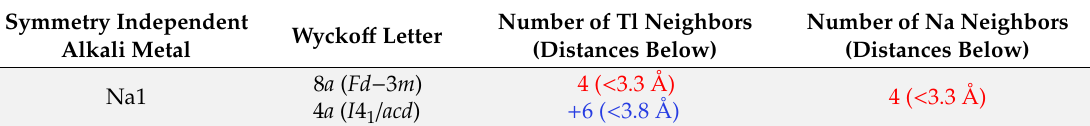
Table 9. Surrounding atoms of the symmetry inequivalent alkali metal position in NaTl (true for both space groups Fd -3 m and I 4 1 / acd ). The color-coding refers to the color of the contacts in Figure 9.